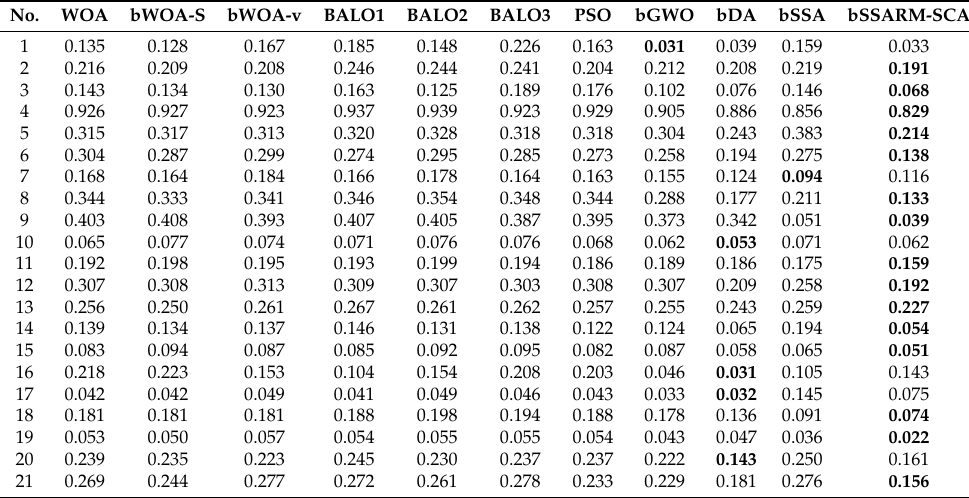
Table 12. Mean fitness statistical metric using large initialization with the 21 utilized